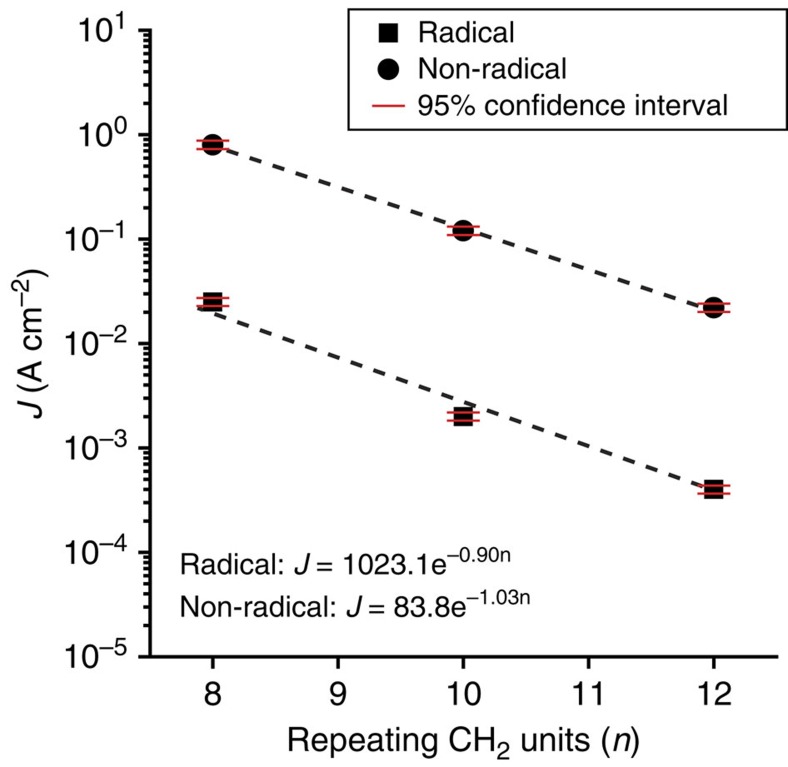
General tunnelling equation fit.The average values of J (A cm−2) at −1.0 V as a function of carbon number (n) for AuTS-SCnPTMR/NR//GaOxcond/EGaIn junctions. The dashed lines represented the fits to the general tunnelling equation. The red error bars represent the 95% confidence interval.